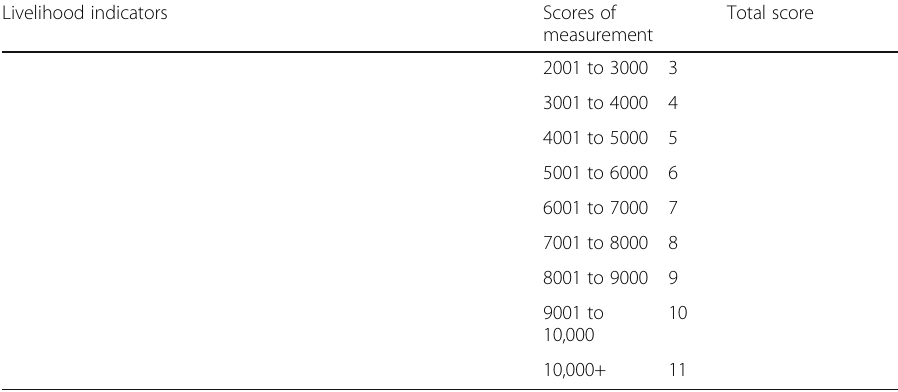
Abbreviations ALSS: Average livelihood status score; ATE: Average treatment effect; ATET: Average treatment effect on the treated; CAADP: Comprehensive Africa Agriculture Development Programme; CGIAR: Consultative Group on International Agriculture Research; CIS: Community-managed irrigation schemes; EBFMPs: Ecosystem-based farm management practices; ECOWAP: ECOWAS Agricultural Policy; GIS: Government-managed irrigation schemes; GSS: Ghana Statistical Service; IFFS: Individual farmers ’ field score; IFIPS: Individual farmer ’ s indicator percentage score; IFPMS: Individual farmer ’ s possible maximum score; IUCN: International Union for Conservation of Nature; IWMI: International Water Management Institute; MoFA: Ministry of Food and Agriculture; POM: Potential outcome mean; UDS: University for Development Studies; UNDP: United Nature Development Programme; WIAD: Women in Agriculture Development;